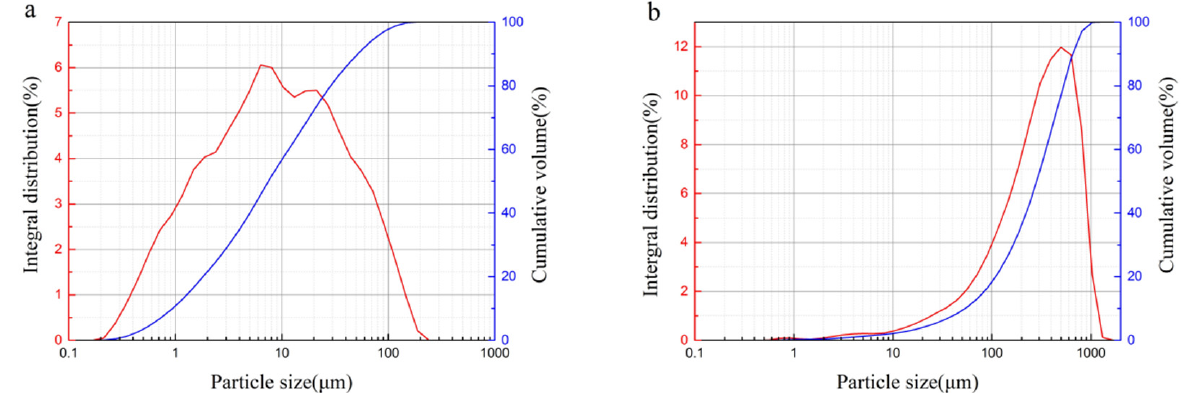
Figure 2. Laser particle size distribution of Bayer red mud ( a ) and fine iron tailings ( b ).